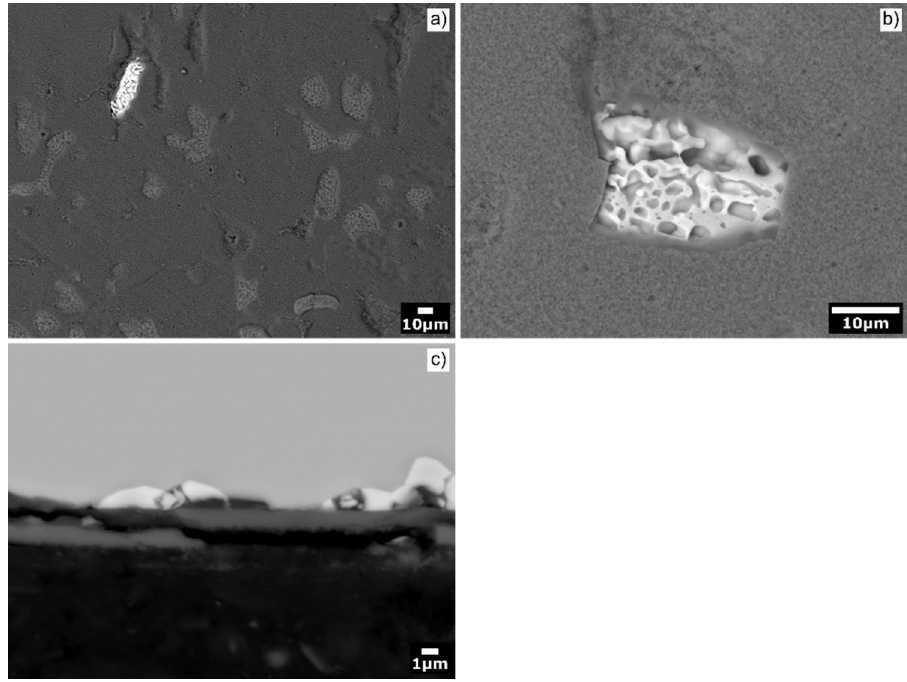
Figure 8. Scale microstructure around β -AlCo dendrites of the Al 71 Co 29 alloy: ( a ) an overview; ( b ) a detailed view; ( c ) cross section image of the scale.